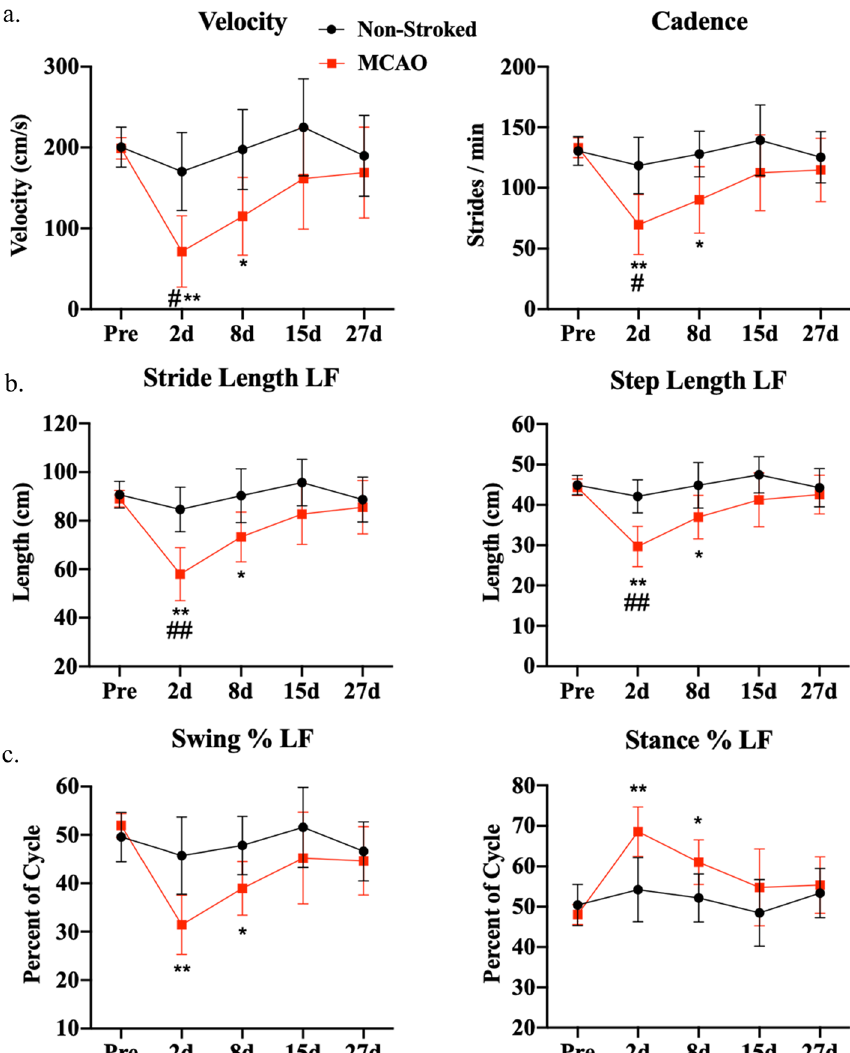
Figure 3. MCAO resulted in acute functional gait deficits. At 2d and 8d post-MCAO, MCAO pigs exhibited significant decreases in velocity ( a ), cadence ( a ), stride length ( b ), step length ( b ), swing percent ( c ), and an increase in stance percent ( c ) relative to pre-MCAO values. At 15d and 27d post-MCAO, there were no significant differences compared to pre-stroke, which was indicative of functional recovery ( p > 0.05). At 2d post-MCAO, MCAO pigs exhibited significantly different velocity ( a ), cadence ( a ), stride length ( b ), and step length ( b ) relative to non-stroked controls. Non-stroked controls had no significant changes over the course of the study ( p > 0.05). * and ** indicated statistical difference from pre-MCAO values. # and ## indicated statistically different between